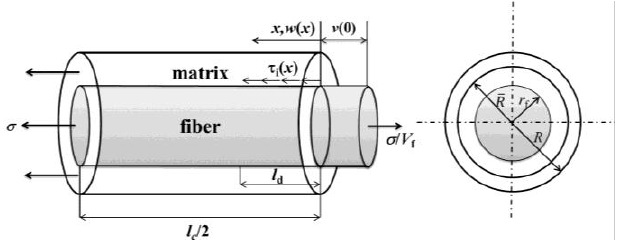
Figure 1. The unit cell of the Budiansky-Hutchinson-Evans shear-lag model.